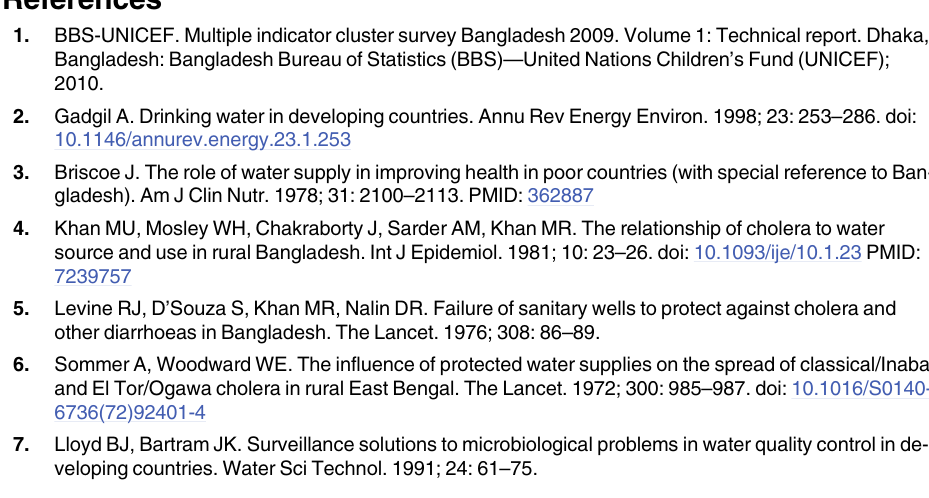
S3 Table. Free chlorine residual among 52 wells at 30 min after chlorination (33 mg tablet in 10 L water). S4 Table. Baseline characteristics in households that completed study vs. were lost to fol- low-up. S5 Table. Baseline characteristics by study group among households that completed the study. S6 Table. E . coli in tubewell and stored water by study group. S7 Table. Prevalence of diarrhea across study arms (2-day and 7-day recall period) among children 8 – 32 mo of age. a